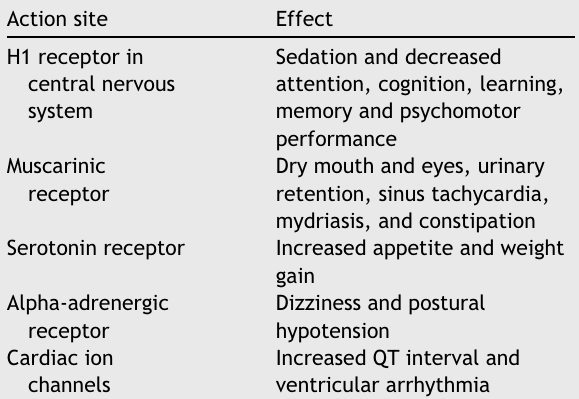
Potential adverse effects of first-generation